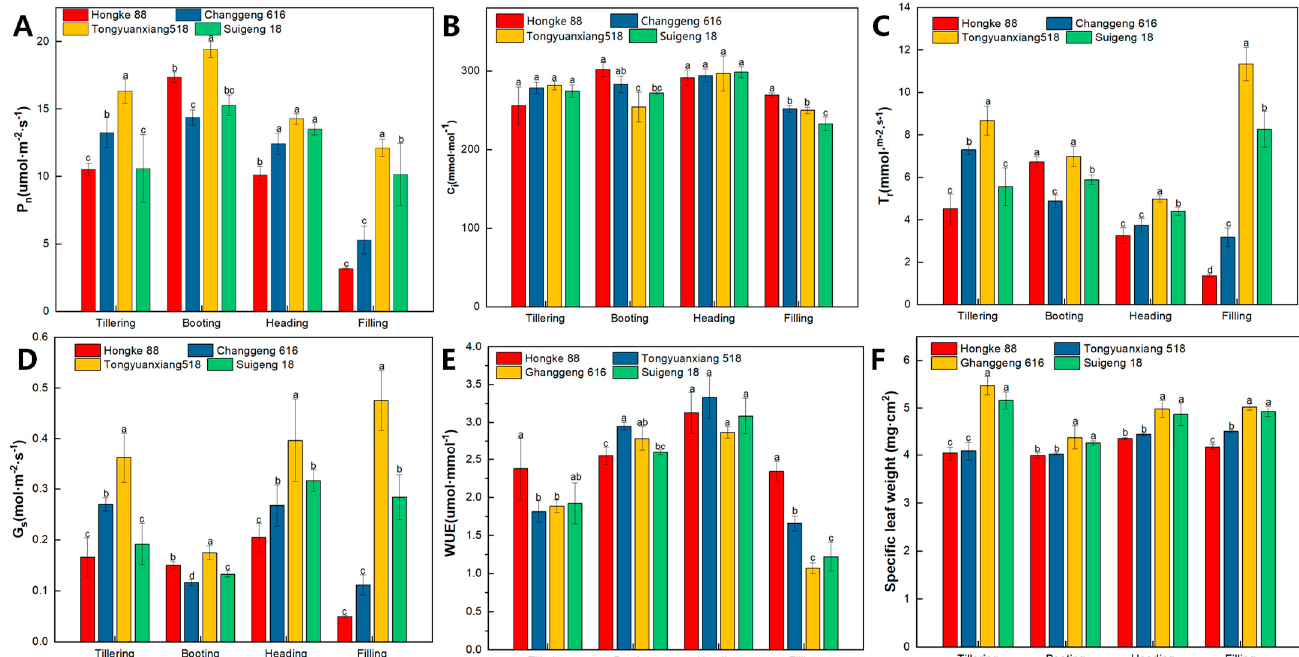
Figure 4. Changes in photosynthetic physiological indicators of different varieties under drought stress in 2021. ( A ), Net photosynthetic rate; ( B ), Intercellular CO 2 concentration; ( C ), Transpiration rate; ( D ), Stomatal conductivity; ( E ), Water-use efficiency; ( F ), Specific leaf weight; Vertical bars represent the S.E. of the means (n = 3). Within each stage of an experiment, means bars marked by the same letters are not significantly different at p < 0.05.